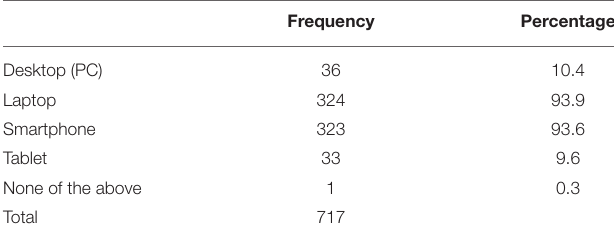
TABLE 9 | Personal devices to support teaching and learning among the students.